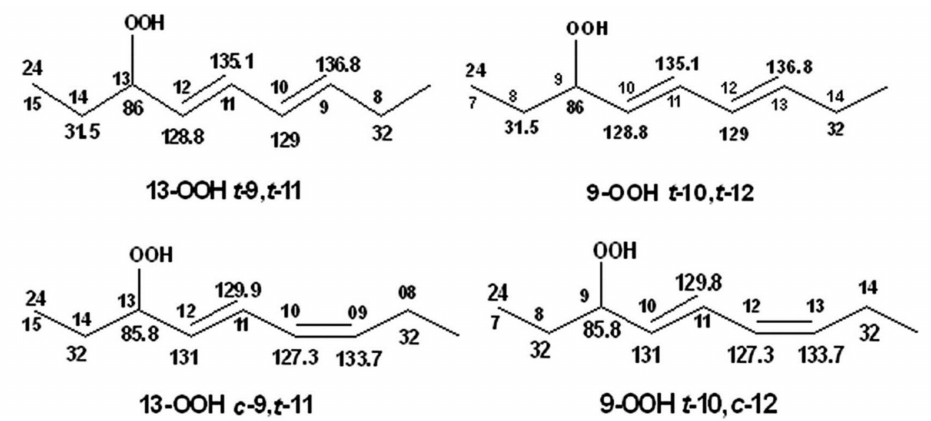
Figure 41. 13 C-NMR chemical shifts of the isomeric hydroperoxides resulting from oxidation of methyl linoleate heated at 70 ◦ C for 8 h